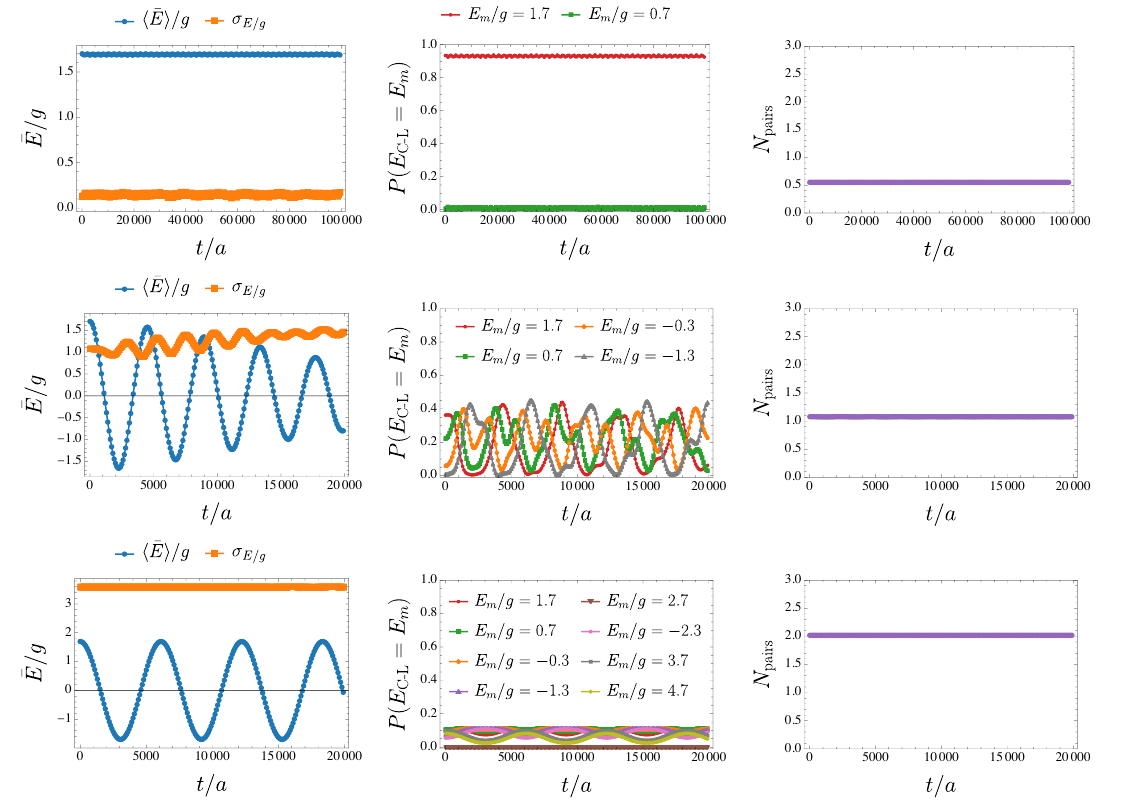
(cid:10) ¯ (cid:11) Figure 6. The expectation values of the spatially averaged electric field E /g , the standard deviation of the spatially averaged electric field σ , the probability to measure field E on the m E/g central link P ( E = E ) , and the number of electron-positron pairs N as functions of time C-L m pairs in the k = 3 . 4 quench for m = 50 , with three different spatial circle sizes mL = 8 (top panel), g mL = 4 (middle panel) and mL = 1 (bottom panel) on an N = 10 lattice. For the same reason as in figure 2, we set l = 10 for mL = 8 , 4 simulations and l = 30 for mL = 1 max max